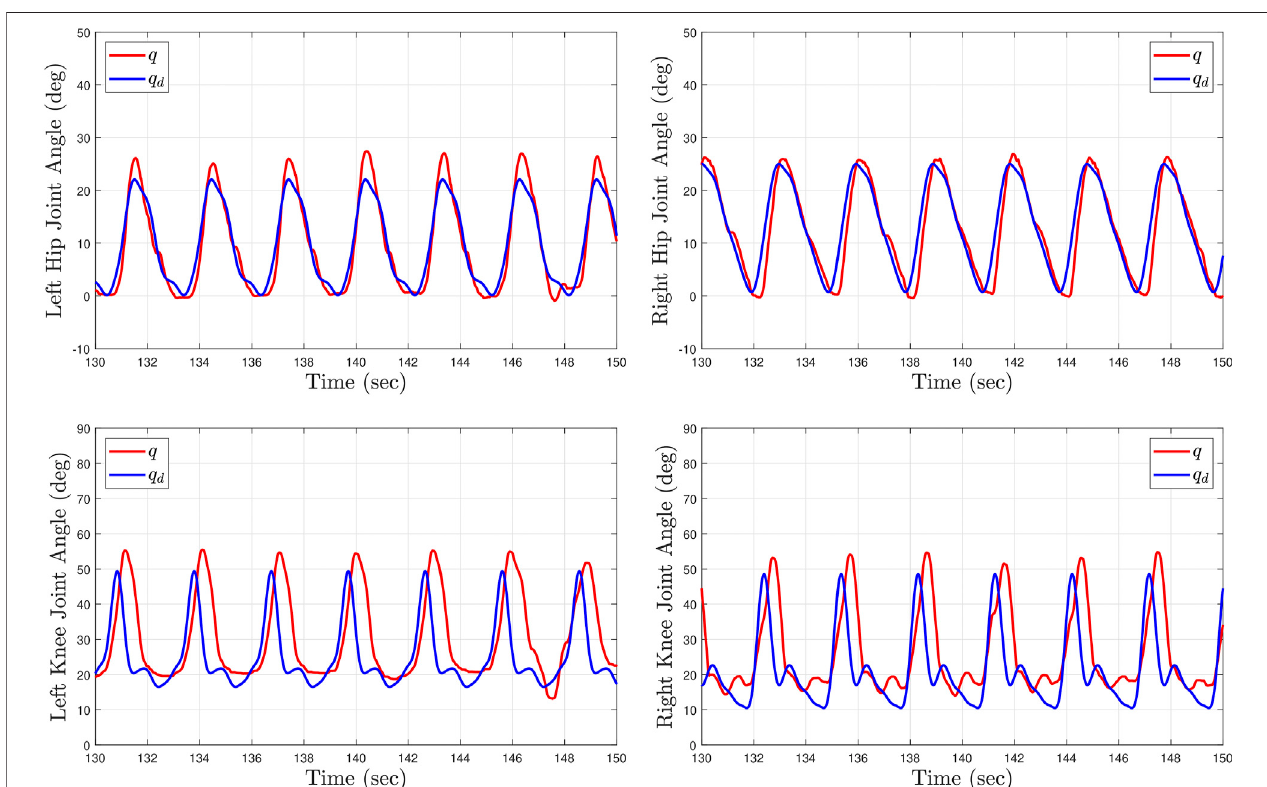
FIGURE7| Kinematic trackingperformanceforSubject1(S1)after2 minutesoftreadmill walkingatlowspeed(0.5 mph).Thetopplotsdepicttheleftandrighthip jointkinematics. The bottom plots depict the left and right knee jointkinematics. The blue curves illustrate the desired kinematic trajectories and thered curves show the actual joint